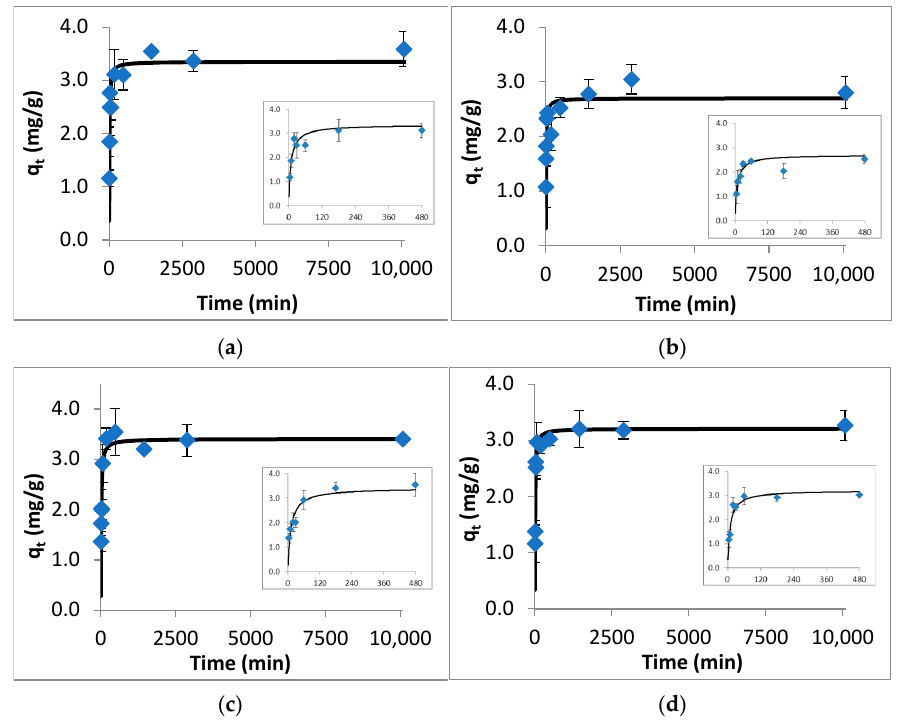
Figure 1. Kinetic data (points) and PSO model fit (solid line) for the adsorption of fluoroquinolones by colemanite. ( a ) Ofloxacin, ( b ) norfloxacin, ( c ) ciprofloxacin, ( d ) enrofloxacin. The results of equilibrium studies, along with the isotherm model fit, are shown in Figure 2. The obtained data were modeled using Langmuir and Freundlich equations. The isotherm model fit results (including the calculated model parameters and statistical measures for the applied models) are given in Table S6. For each target compound, the Langmuir model fits better to the equilibrium data than the Freundlich model, with high R 2 and low χ 2 and NRMSE values. While the Langmuir model describes monolayer ad- sorption with a homogeneous surface and energy on the adsorbent surface, the Freun- dlich model expresses multilayer adsorption with heterogeneous energy distribution of the active sites. In this regard, the obtained results indicate the energetically homogene- ous surface of the colemanite with the monolayer adsorption of fluoroquinolone antibi- otics on it. The highest maximum Langmuir adsorption capacity (Q max ) of colemanite was